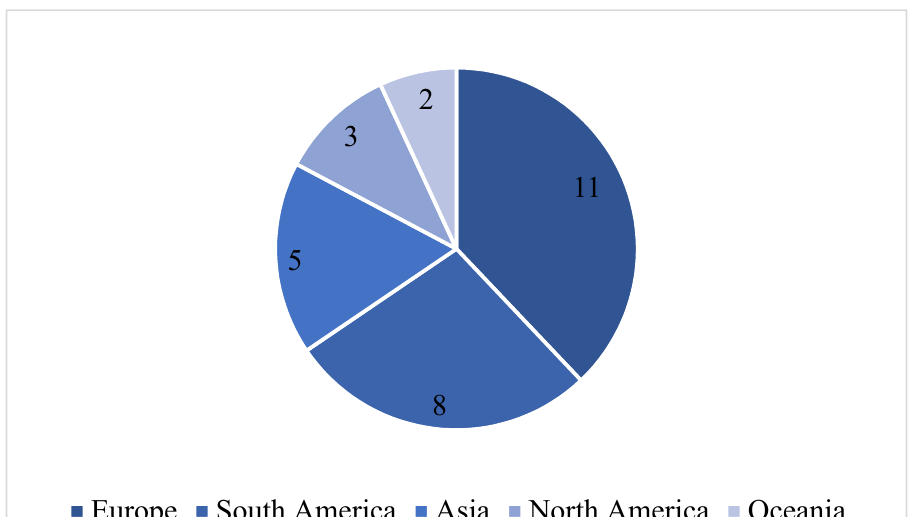
Figure 1. HEI distribution per geographical region.